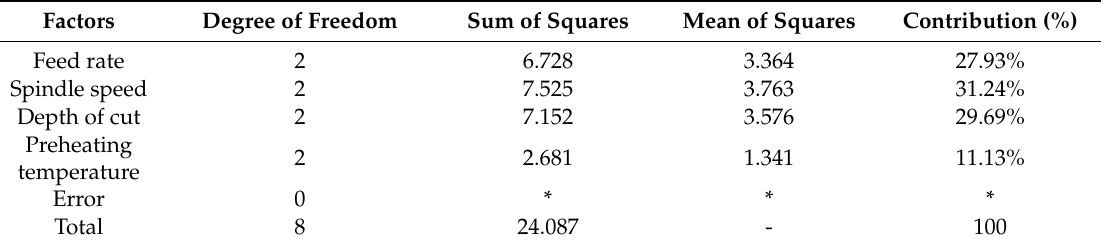
Table 10. The analysis results of variance for surface